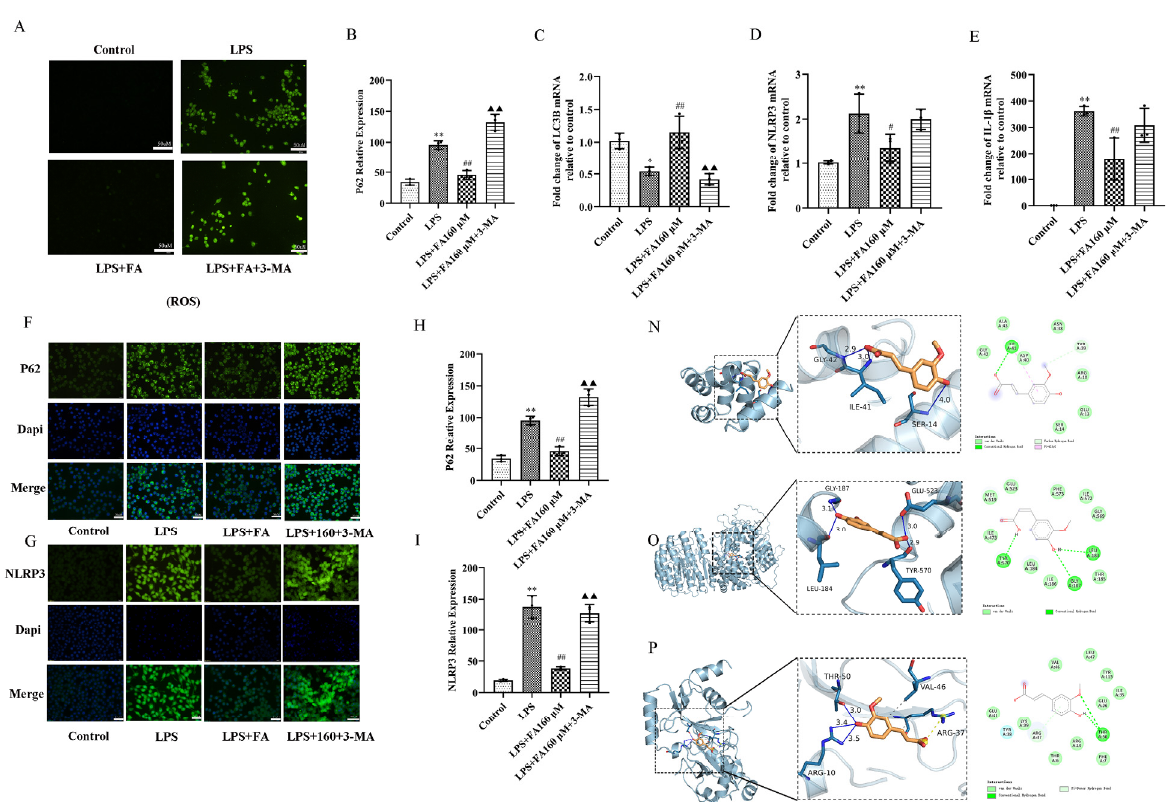
Figure 5. Autophagy inhibitors (3-MA) block the protective e ff ects of FA: restoring autophagy and inhibiting in fl ammation levels. ( A ) ROS was detected via DCF-DA fl uorescent probe. ( B – E ) The qPCR kit was used to detect autophagy-related proteins P62 and LC3; and NLRP3 and IL-1 β . ( F – I ) The expression of NLRP3 and P62 (50× magni fi cation) in BV2 microglia was observed via inverted fl uorescence microscope. The nuclei were stained with Hoechst 33,342 (blue). Scale bar = 20 µM. ( N – P ) Molecular docking results of ferulic acid with LC3, NLRP3 and P62 proteins. Data are means ± standard deviations (SDs) ( n = 3). ** p < 0.01, * p < 0.05, vs. control; ## p < 0.01, # p < 0.05, vs. LPS; ▲▲ p < 0.01, vs. FA + LPS.